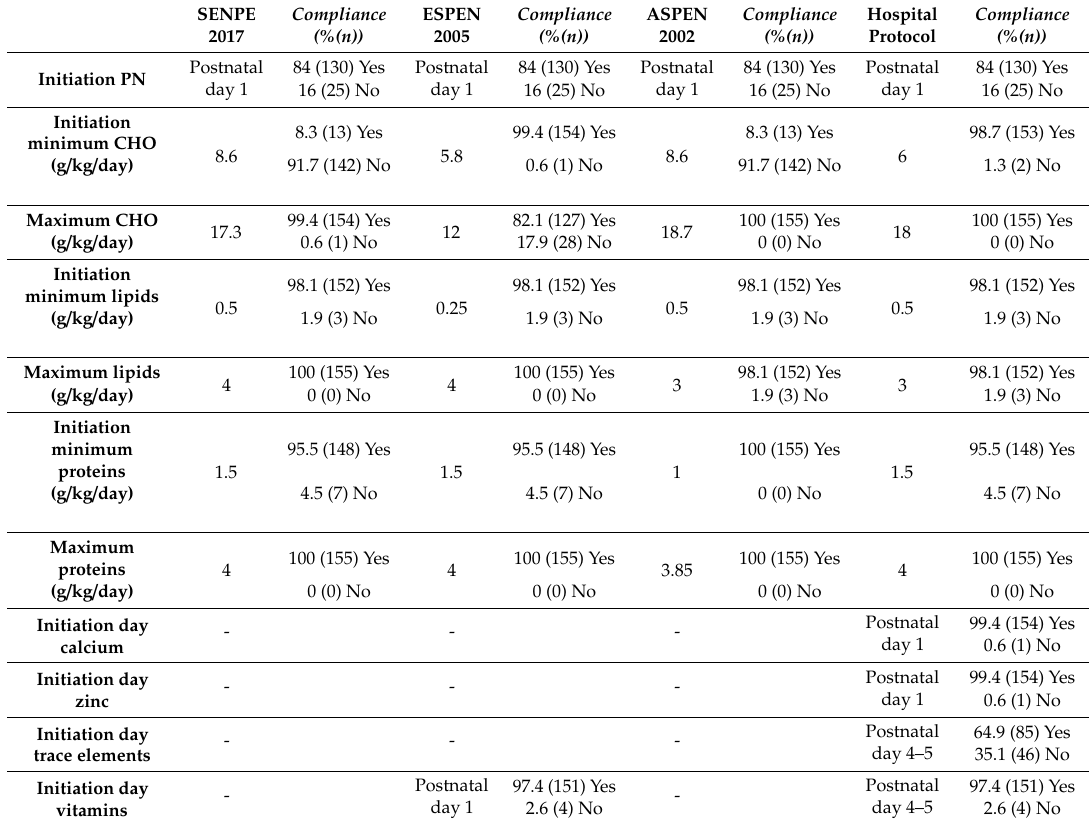
Table 3. The results show that the macronutrient intakes were adjusted to the established hospital protocol (compliance was 95.5% to 100%), as was the initiation of calcium (99.4%), zinc (99.4%) and vitamins (97.4%) However, as indicated, in preterm infants who continued with PN for more than 4 days, the initiation of trace elements on days 4 or 5 was not frequently prescribed (35.1%), with compliance in this case of 64.9%. Table 3. Compliance with the guidelines published by SENPE, ESPEN and ASPEN and with the established hospital